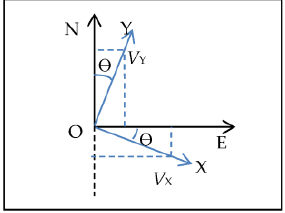
Figure 2. Diagram of coordinate system transformation.